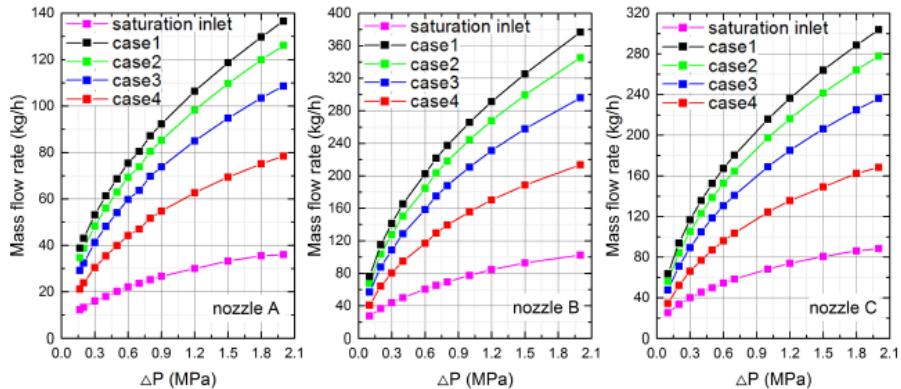
Figure 6. Variation of the mass flow rate of liquid nitrogen for the three tested nozzles at different inlet temperatures [46]. Reprinted from [46], Copyright (2017), with permission from Elsevier.